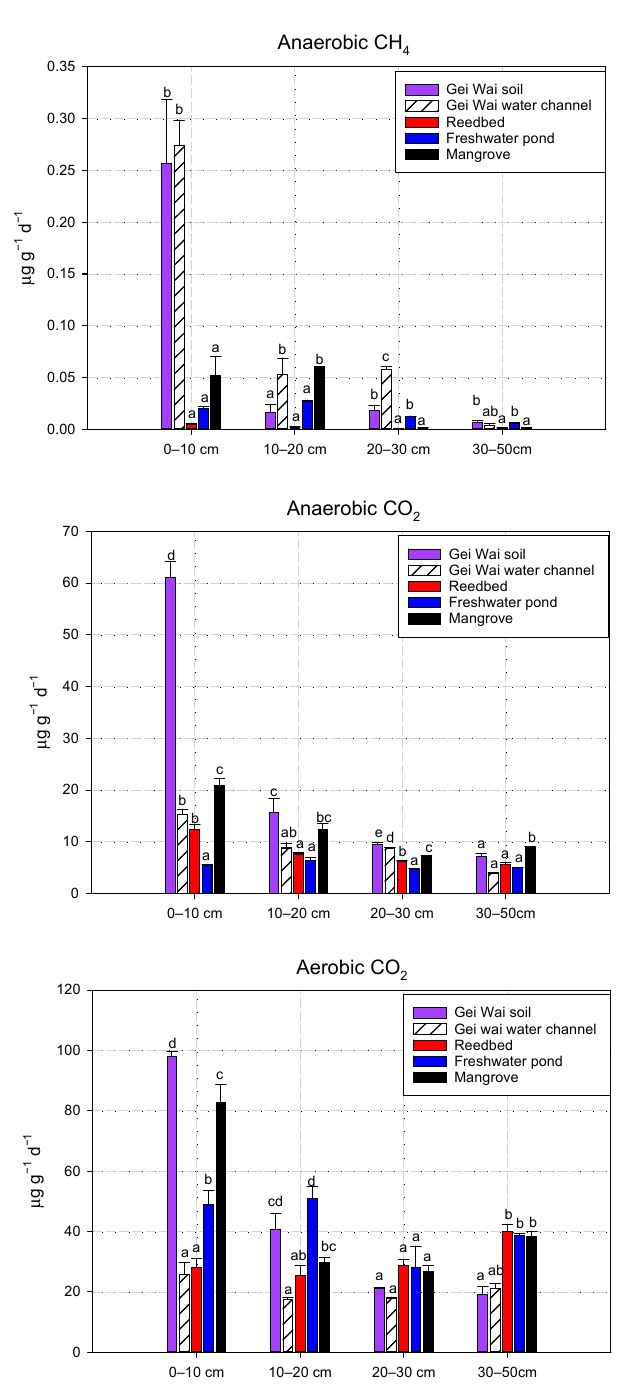
Figure 2. Mean anaerobic CH 4 , anaerobic CO 2 , and aerobic CO 2 production potentials at different soil depths for the five land use types. Data are means ± standard deviation. Different letters indicate significant differences in rates among the land use types at a given depth ( p < 0.05).